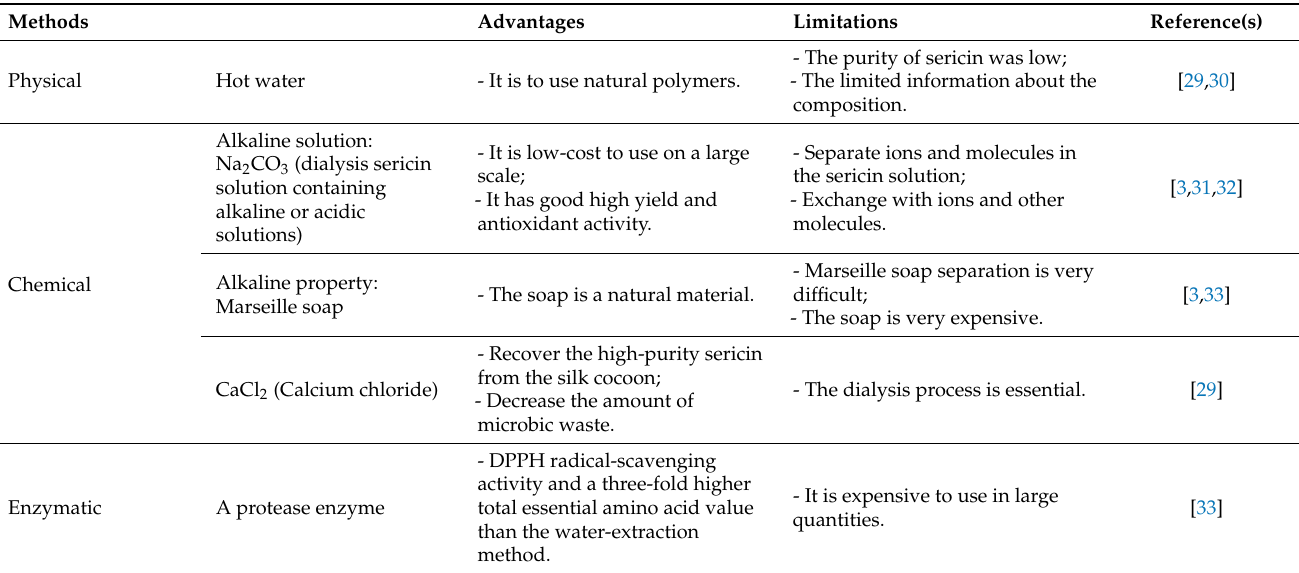
Table 1. Different methods of extraction of sericin, their advantages, and their